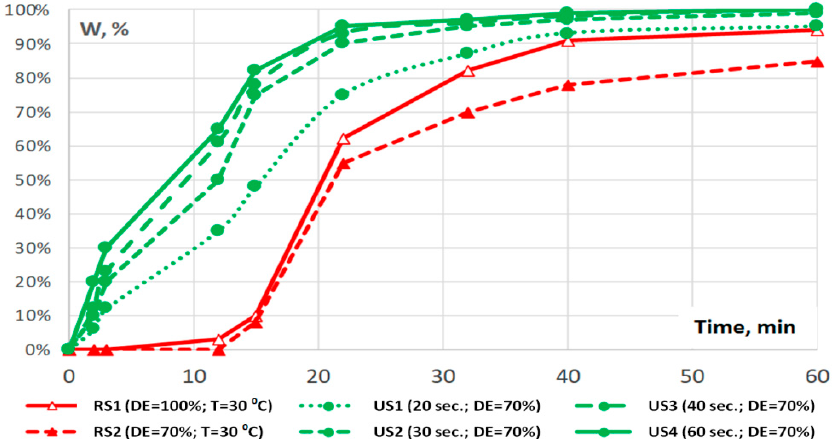
Figure 9. Kinetics of water fallout at a W/OE temperature of 30 ° С depending on the time of ultrasound exposure (W/O = 67%). ultrasound exposure (W/O = 67%).